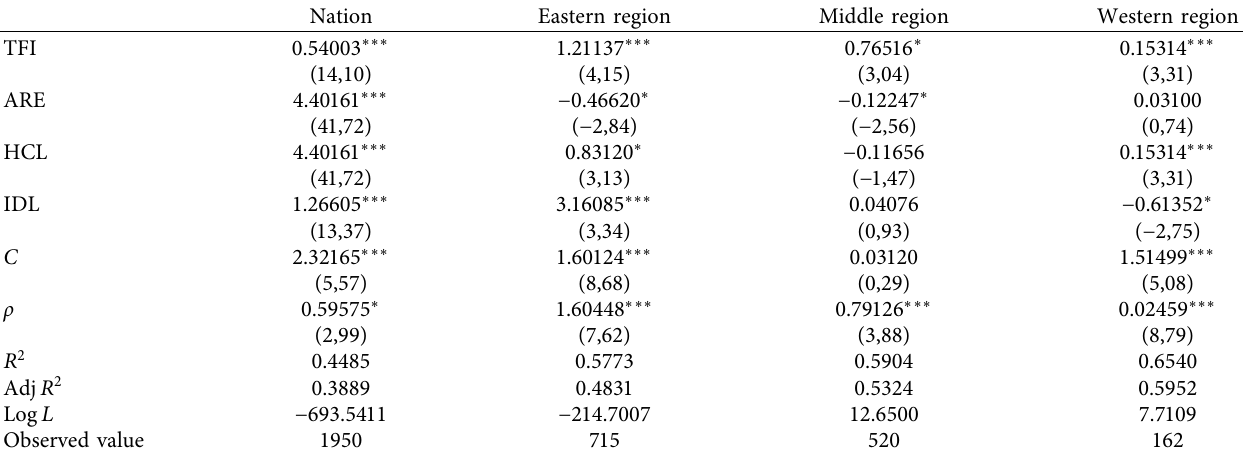
Table 6: Results of the robustness test on the national sample and regional